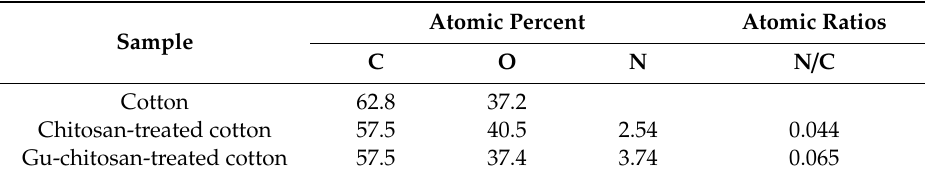
Figure 7. XPS spectra of the prepared fabrics: ( a ) untreated cotton fabric; ( b ) chitosan-treated cotton fabric; and ( c ) Gu-chitosan-treated cotton fabric. Table 2. Surface atomic concentration of the untreated, chitosan-treated, and Gu-chitosan-treated cotton fabrics.